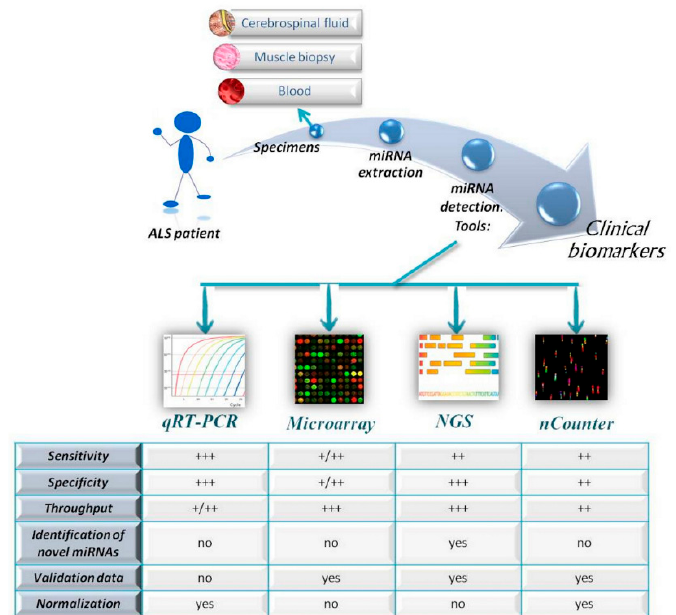
Figure 1. MicroRNA (miRNA)-based biomarkers in amyotrophic lateral sclerosis (ALS) patients. Schematic workflow to identify possible miRNAs as biomarkers starting from ALS patients’ sample using different quantitative approaches. The comparison among the common characteristics of miRNA detection platforms is summarized in the figure. Sensibility, specificity and throughput are classified as follows: +++ (very high), ++ (moderate), +/++ (moderate to low) and + (low). Abbrevations: qRT-PCR, quantitative Real-Time Polymerase Chain Reaction; NGS, Next Generation Sequencing.